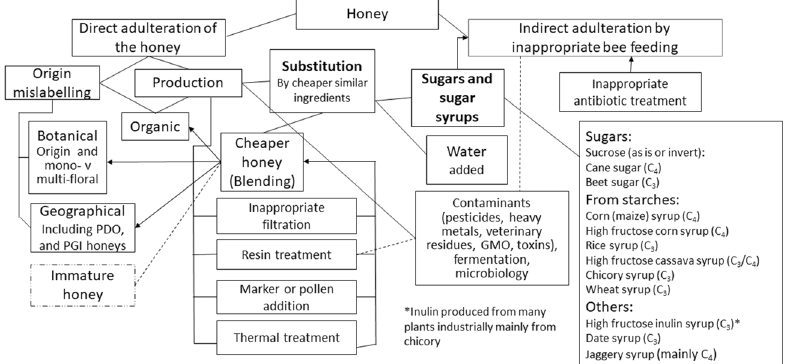
Fig. 2 Types of honey adulteration [Sources: Anklam 1998, 17 Soares et al., 2017, 21 European Commission 2018, 22 Ayton et al., 2019, 32 Se et al., 2019 34 and Chin & Sowndhararajan, 2020 35